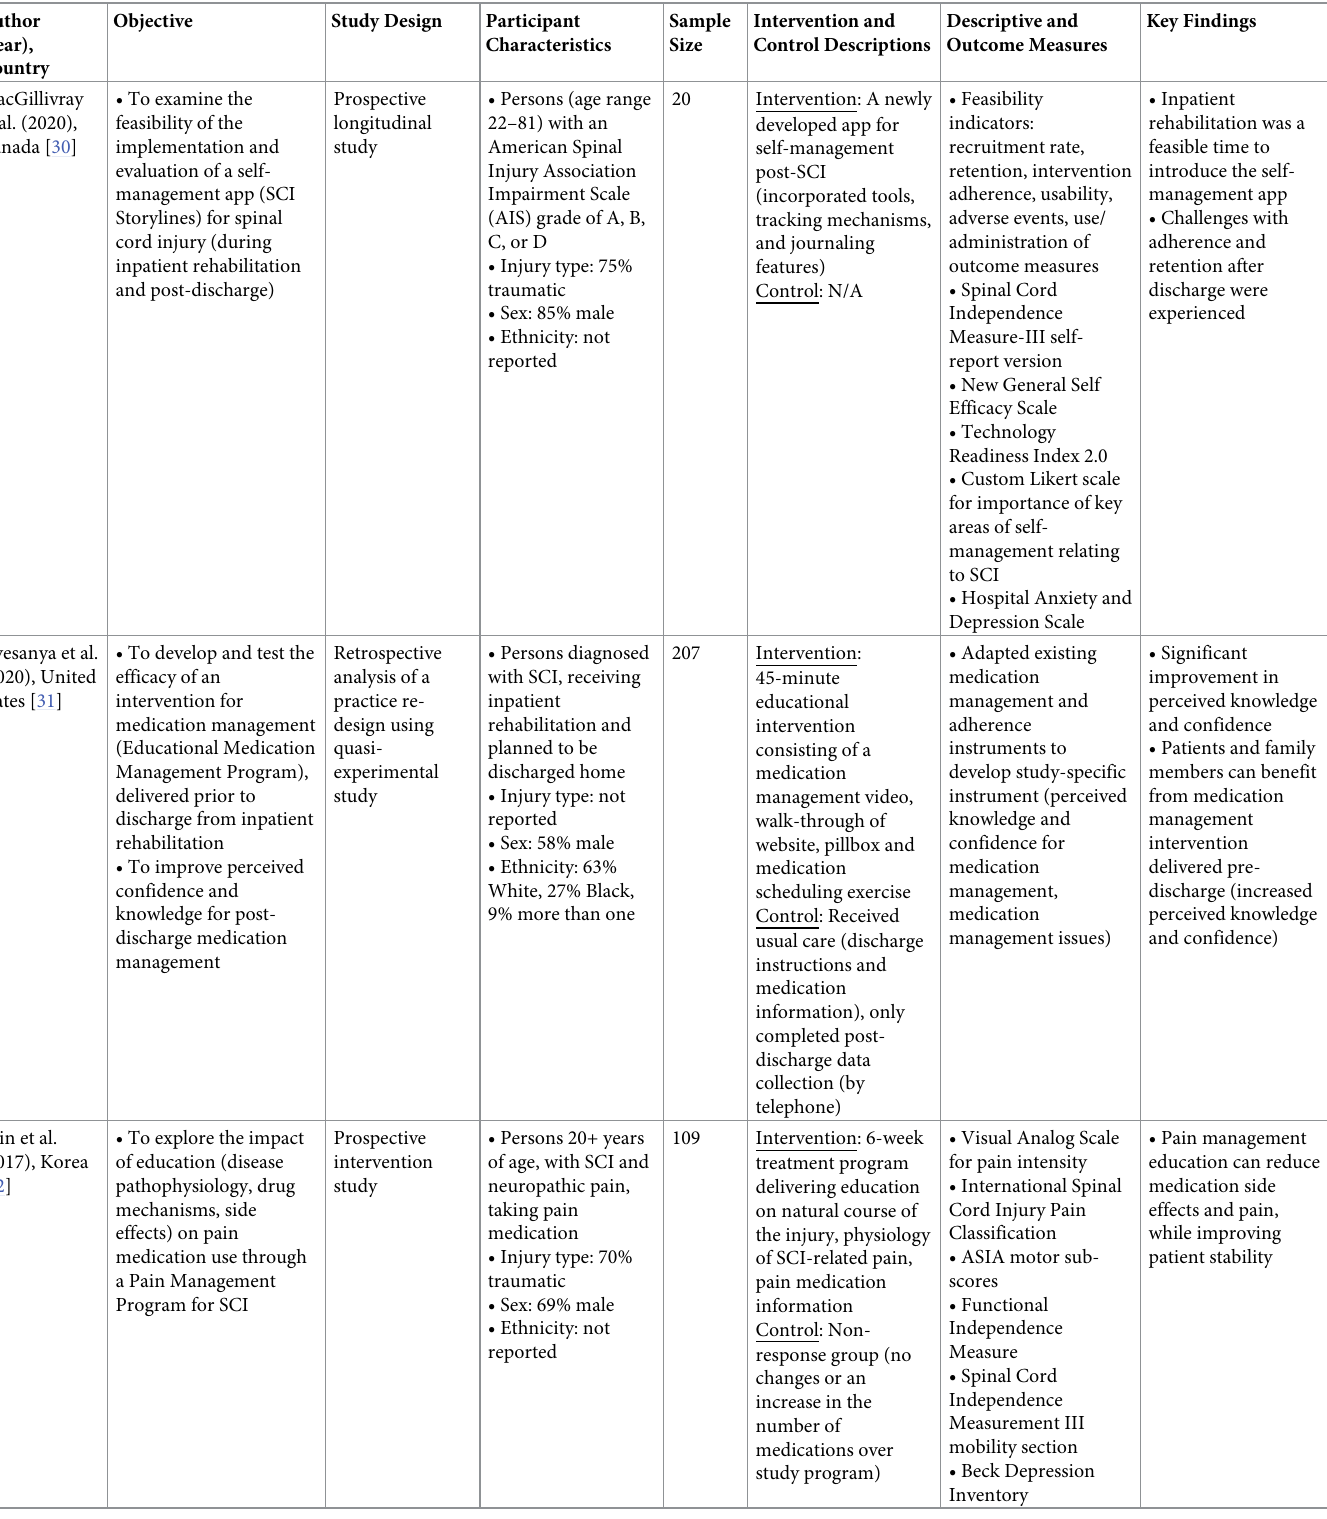
Table 1. Characteristics of included articles (n =